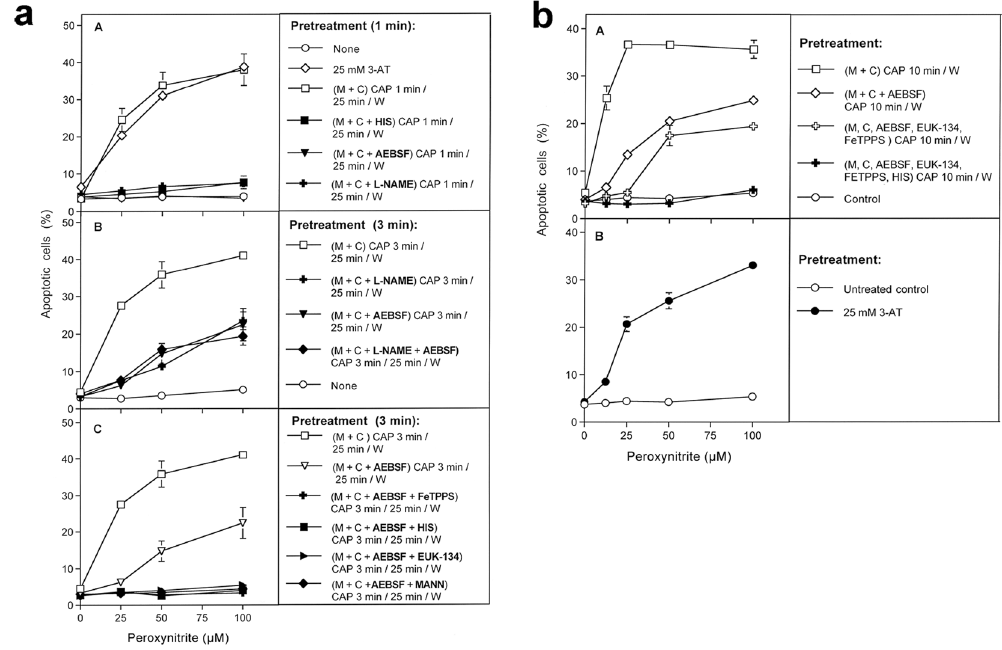
Figure 5. Demonstration of catalase inactivation by primary singlet oxygen ( 1 O 2 ) derived from long-lived species of CAP-treated medium or from the gaseous phase of CAP. ( a ) Catalase inactivation solely by primary singlet oxygen generated from long-lived species of CAP treated medium requires extending the time of CAP treatment and blocking the generation of secondary singlet oxygen ( 1 O 2 ). The experiment described in this Figure followed the same principles and used the same concentrations of inhibitors as described before in Fig. 4, but includes a variation of the time of CAP treatment. A confirms that the catalase inhibitor 3-AT as well as pretreatment of tumor cells with CAP for 1 min, followed by 25 min in the same medium allowed for inactivation of tumor cell protective catalase, as determined by a peroxynitrite (ONOO − ) challenge. Part A also confirms that catalase inactivation is mediated by 1 O 2 (inhibition by histidine (HIS)) and that primary 1 O 2 is not sufficient for catalase inactivation under these conditions, as inhibition of NOX1 by AEBSF or NOS by L-NAME during pretreatment and incubation completely prevented catalase inactivation through inhibition of secondary singlet oxygen generation. B. When CAP treatment was extended to 3 min, followed by 25 min incubation in the same medium, significant catalase inactivation was determined despite the presence of L-NAME or AEBSF, i. e. even under conditions where secondary 1 O 2 generation is inhibited. C. As inactivation of catalase in the presence of AEBSF is inhibited by the parallel presence of either the 1 O 2 scavenger histidine (HIS), the ONOO − decomposition catalyst FeTPPS, the catalase mimetic EUK-134 or the ⋅ OH radical scavenger mannitol (MANN), the underlying effect of primary 1 O 2 is confirmed and its generation through the interaction of long-lived species derived from CAP is assured. The action of 1 O 2 directly derived from CAP is excluded as a significant effective source, as its potential action would not have been inhibited by either FeTPPS, mannitol or EUK-134. Statistical analysis: Apoptosis induction by all concentrations of ONOO − after treatment with CAP for 1 or 3 min is highly significant (p < 0.001). The effects of all inhibitors shown under A-C are highly significant (p < 0.001). There is no significant difference between the effects of L-NAME, AEBSF or their combination on apoptosis induction after 3 min CAP treatment and ONOO − challenge. ( b ) Demonstration of the effect of primary singlet oxygen ( 1 O 2 ) derived directly from the gaseous phase of CAP. The peroxynitrite (ONOO − ) challenge was used for the determination of catalase inactivation as in the previous experiments. A. Extension of the treatment time of cells in medium (M + C) with CAP to 10 min resulted in massive inactivation of catalase, even if there was no further incubation step after CAP treatment ((M + C) CAP 10 min/W). When the generation of secondary 1 O 2 was prevented by the presence of the NOX inhibitor AEBSF (100 µ M) during CAP treatment ((M + C + AEBSF) CAP 10 min/W), the degree of catalase inactivation was strongly lowered. Under these conditions, catalase inactivation must be due to primary 1 O 2 that may be generated by long-lived species from CAP-treated medium and/or by 1 O 2 directly derived from CAP. When the generation of secondary 1 O 2 was inhibited by AEBSF and the generation of primary 1 O 2 from long-lived species in CAP- treated medium was blocked through the addition of EUK-134 and FeTPPS, the degree of catalase inactivation was further reduced ((M,C,AEBSF, EUK-134, FeTPPS) CAP 10 min/W). This residual inactivation seemed to be mediated by primary singlet oxygen derived directly from CAP, as its effect was prevented through the presence of histidine in the assays (M,C,AEBSF, EUK-134, FeTPPS, HIS ) CAP 10 min/W). Statistical analysis: Apoptosis induction after CAP treatment is highly significant for all concentrations of ONOO − (p < 0.001). CAP treatment in the presence of AEBSF caused highly significant apoptosis induction by ONOO − at 25 µ M and higher, CAP treatment in the presence of AEBSF, EUK-134 and FeTPPS caused highly significant apoptosis induction at 50 µ M ONOO − and higher (p <